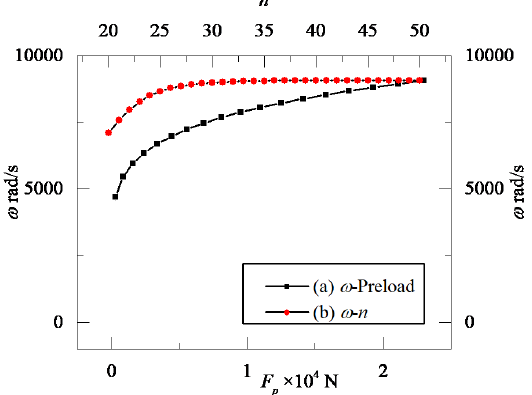
Figure 9. Effects of the preload and frequency index on the natural frequency of the rod fastening rotor system.